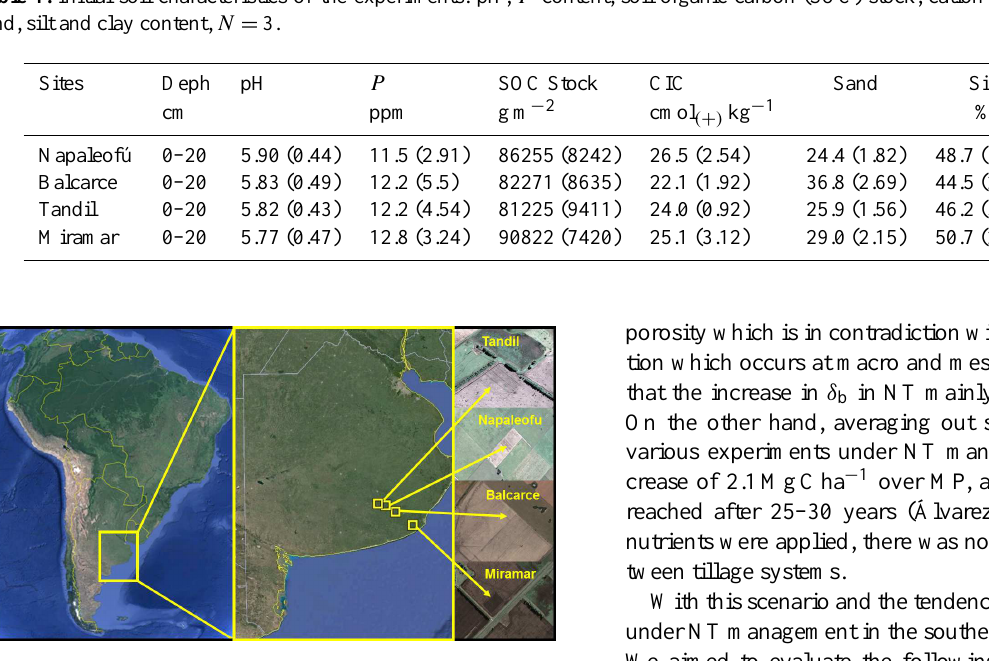
Figure 1. Experiment geographic